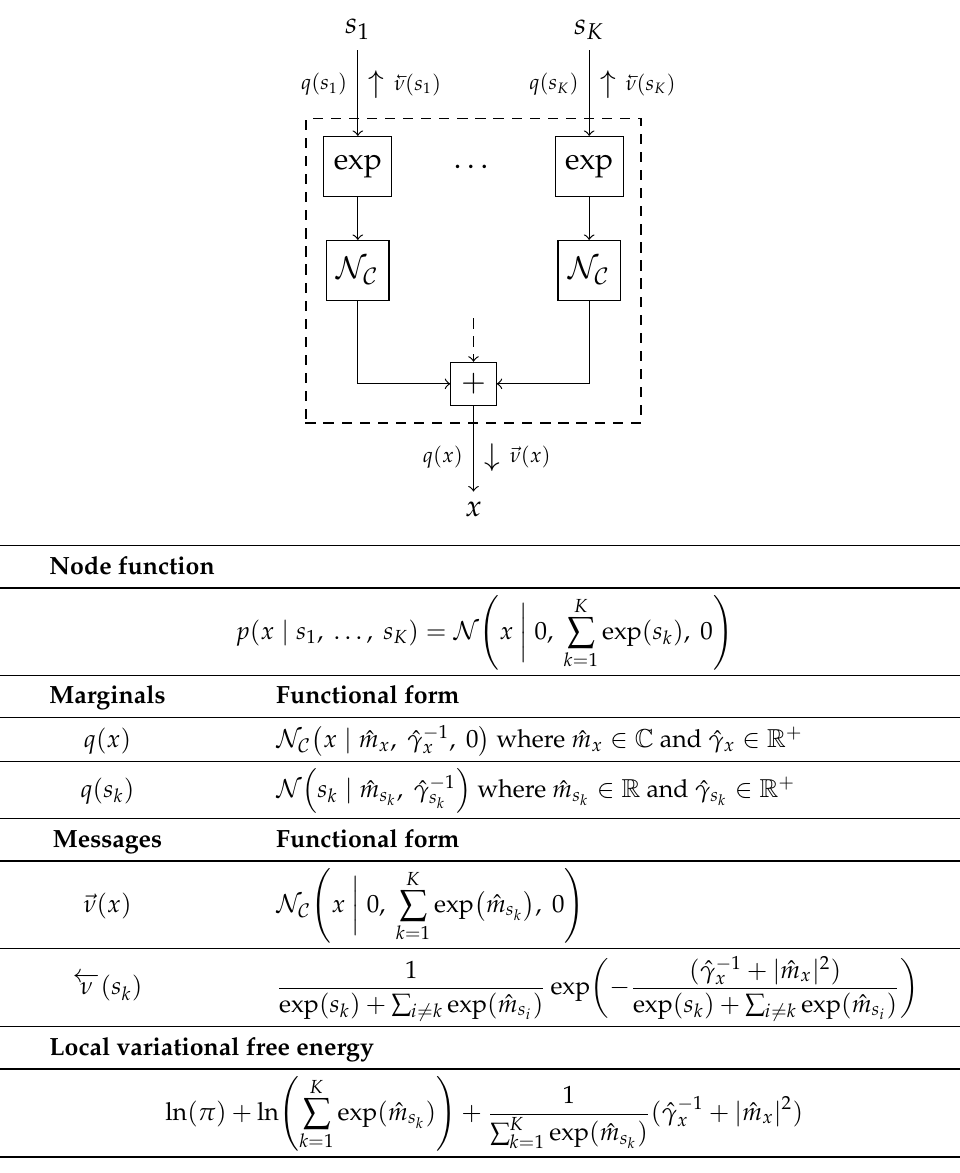
The message ←− ν ( s k ) has been calculated by approximating the intractable terms using a vector Taylor expansion over all variables, except for s k . Alternative approaches are also feasible. For example, approximating the intractable terms using a full vector Taylor expansion (also over s k ), as with the Algonquin node, is also feasible, although this